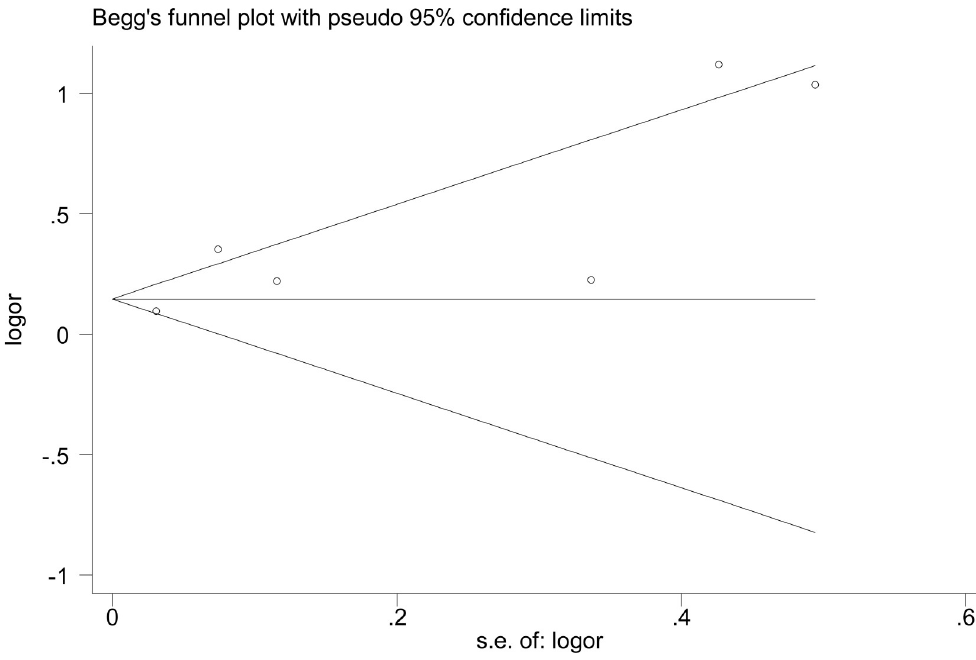
Fig 3. Funnel plot of helicobacter pylori and